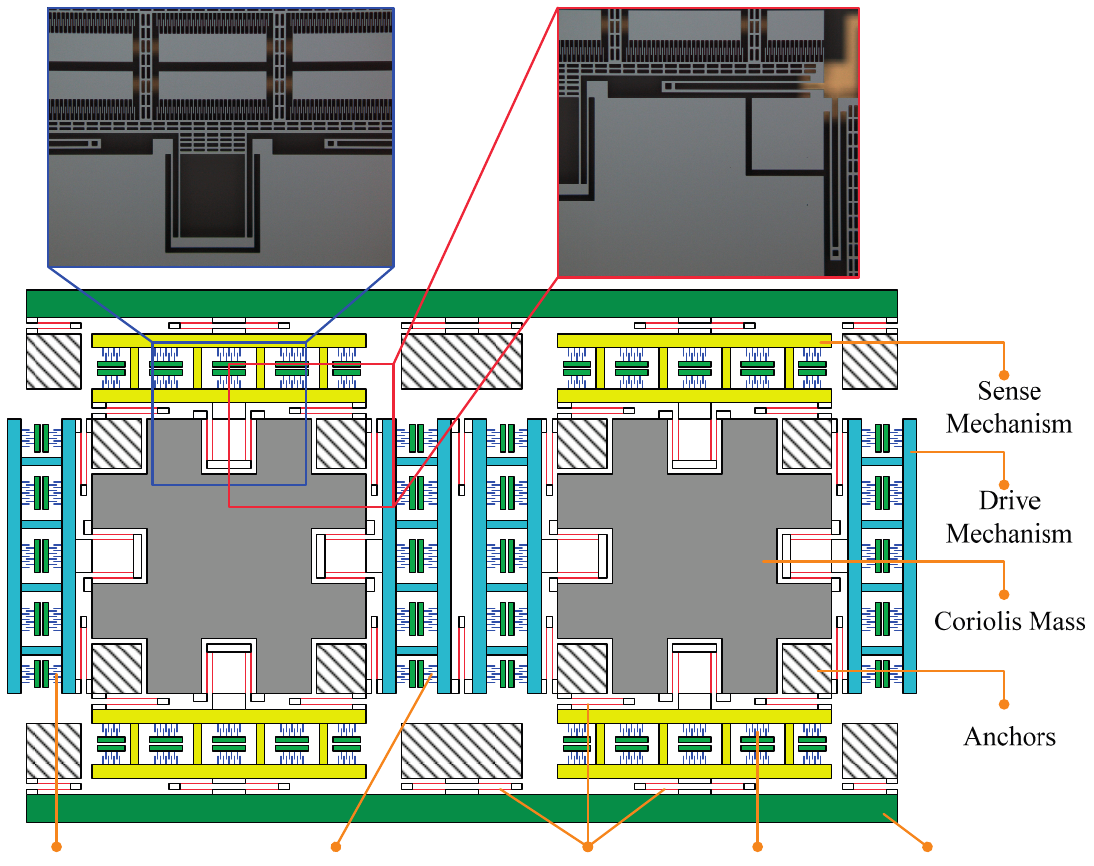
Figure 6. Mechanical structure of the designed tuning fork